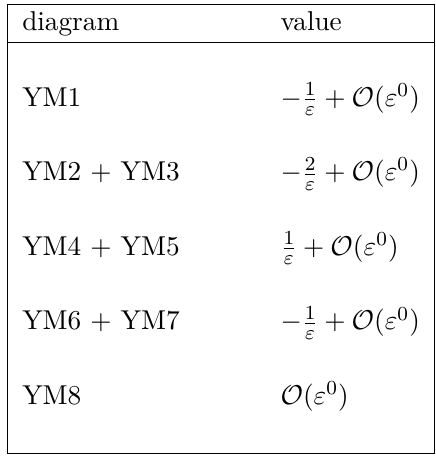
2 S (¯ x t − ¯ y t ) 0 (4 π ) 2